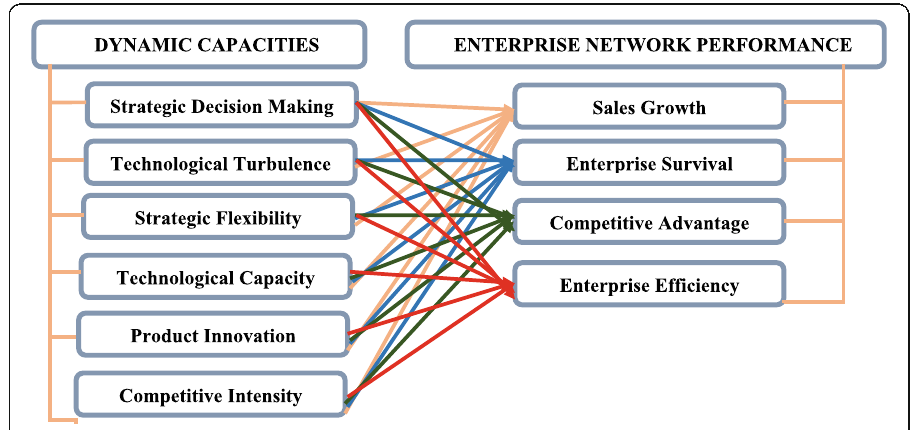
Fig. 3 Interconnections of dynamic capacities and enterprise performance. Source: Authors ’ work